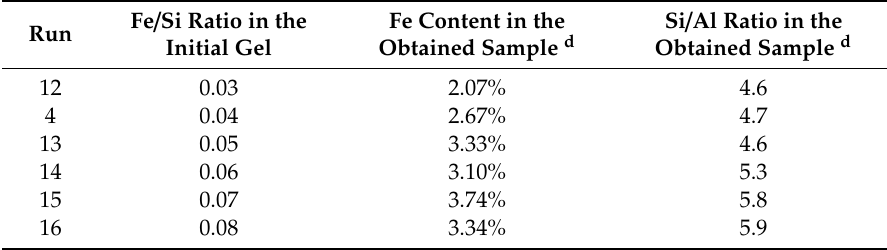
Figure 6. XRD patterns of Fe-LTL zeolite crystals synthesized under various conditions in Table 2. ( A ) XRD patterns of Fe-LTL zeolite crystals synthesized with different K 2 O/SiO 2 ratios; ( B ) XRD patterns of Fe-LTL zeolite crystals synthesized with different SiO 2 /Al 2 O 3 ratios; ( C ) XRD patterns of Fe-LTL zeolite crystals synthesized with different FeCl 3 /SiO 2 ratios. Table 3. Fe / Si and Si / Al ratios of di ff erent samples.